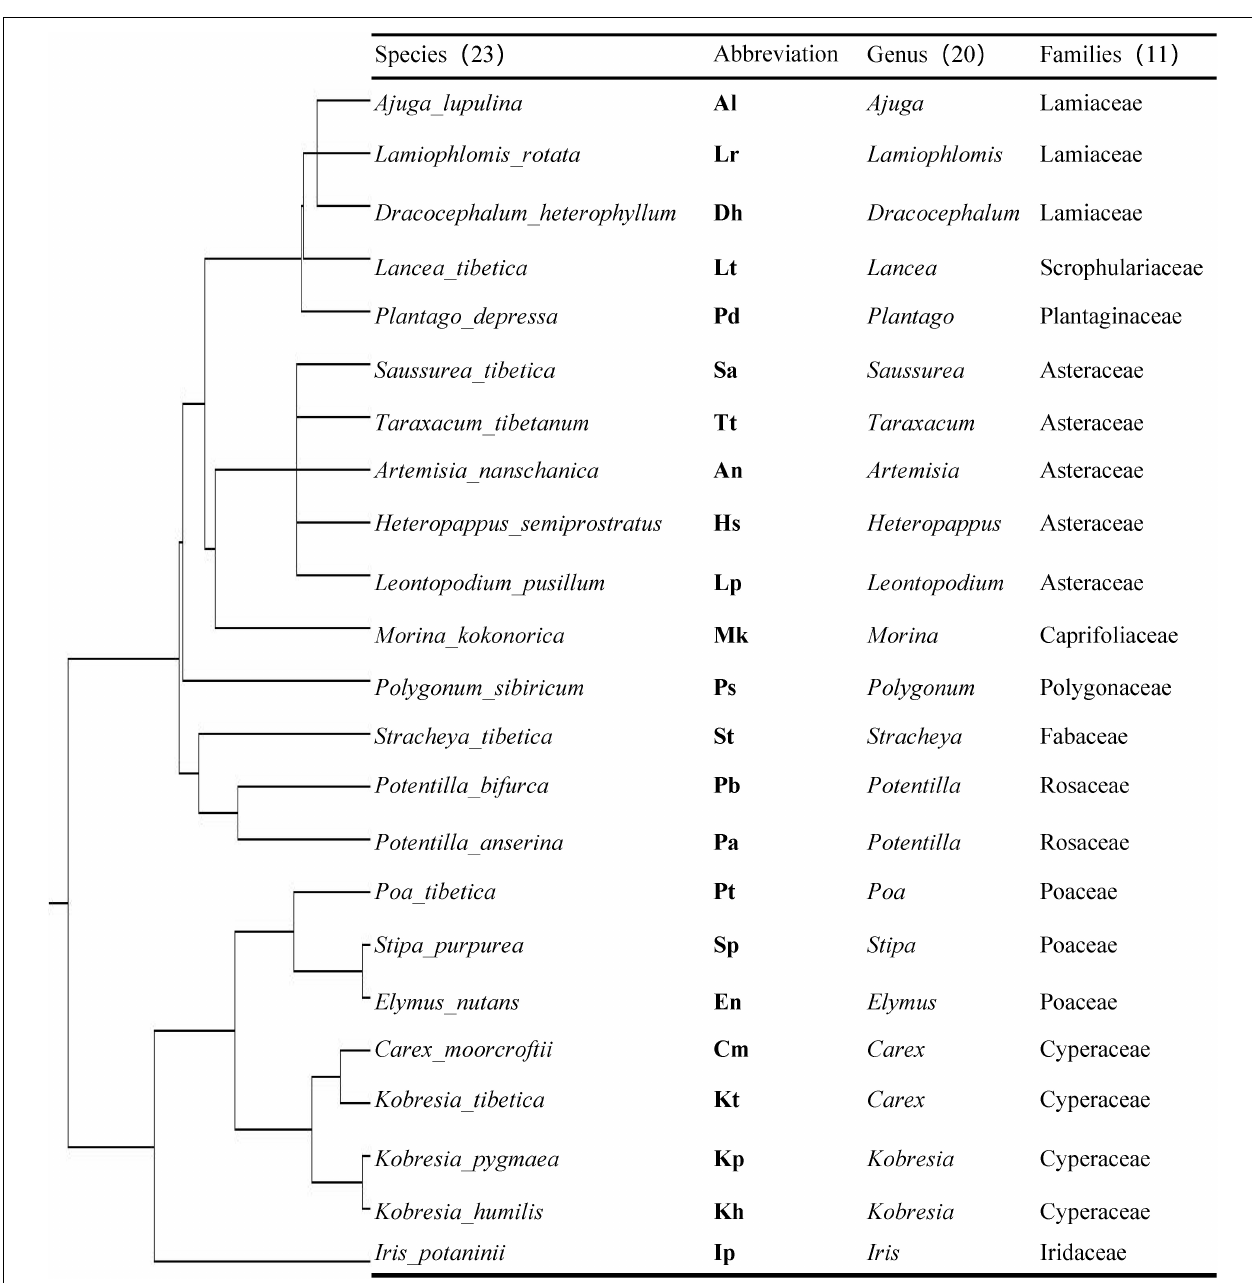
at 200 × microscopes (McGonigle et al.,